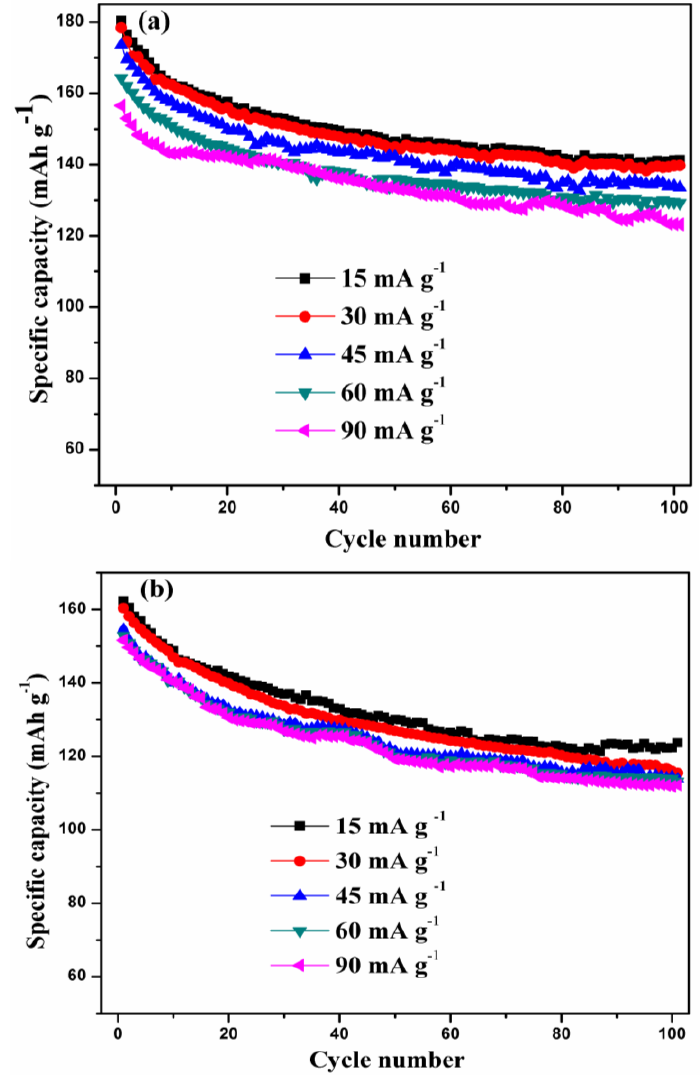
Figure 6. Rate capabilities of the LVPBC ( a ) and pristine LVPC ( b ) composites in the voltage range of